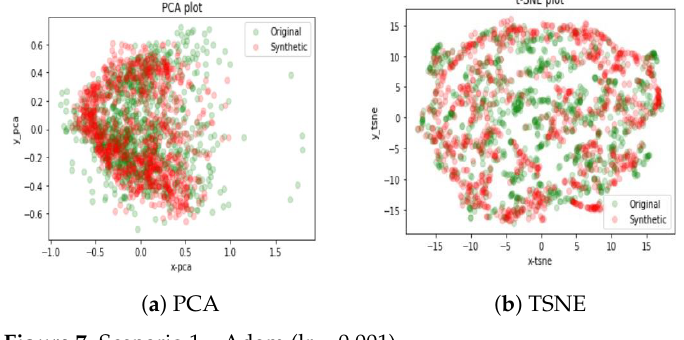
Figure 7. Scenario 1—Adam (lr = 0.001).